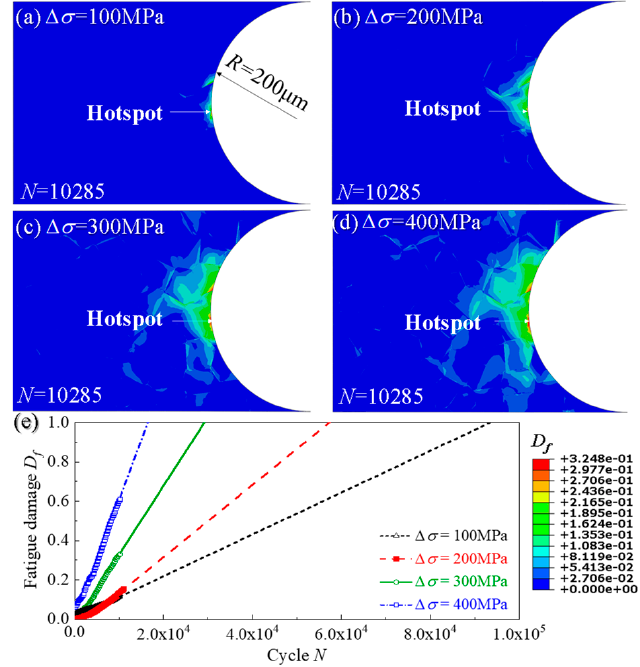
Figure 9. Distribution of fatigue damage of notch specimen ( R = 200 μ m) with 4 stress ranges: ( a ) 100 MPa; ( b ) 200 MPa; ( c ) 300 MPa; ( d ) 400 MPa and ( e ) the evolution curves of D f of the hotsopts from ( a – d ).